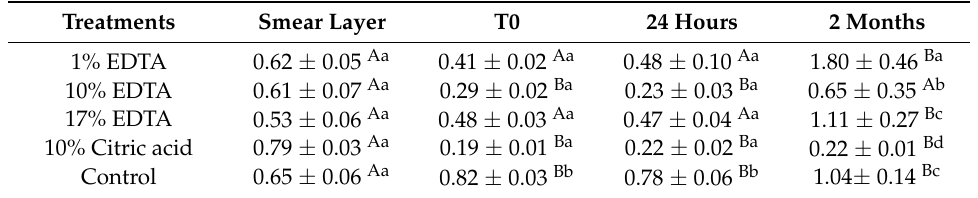
Table 3. P/N atomic ratios (mean ± SD). In columns, identical superscript lowercase letters represent no statistical differences (two-way ANOVA followed by an RM Student–Newman–Keuls test) among tested solutions ( P ≥ 0.05). In the horizontal rows, identical superscript uppercase letters represent no statistical differences (one-way ANOVA for repeated measures followed by an RM Student–Newman–Keuls test) among evaluation times ( P ≥